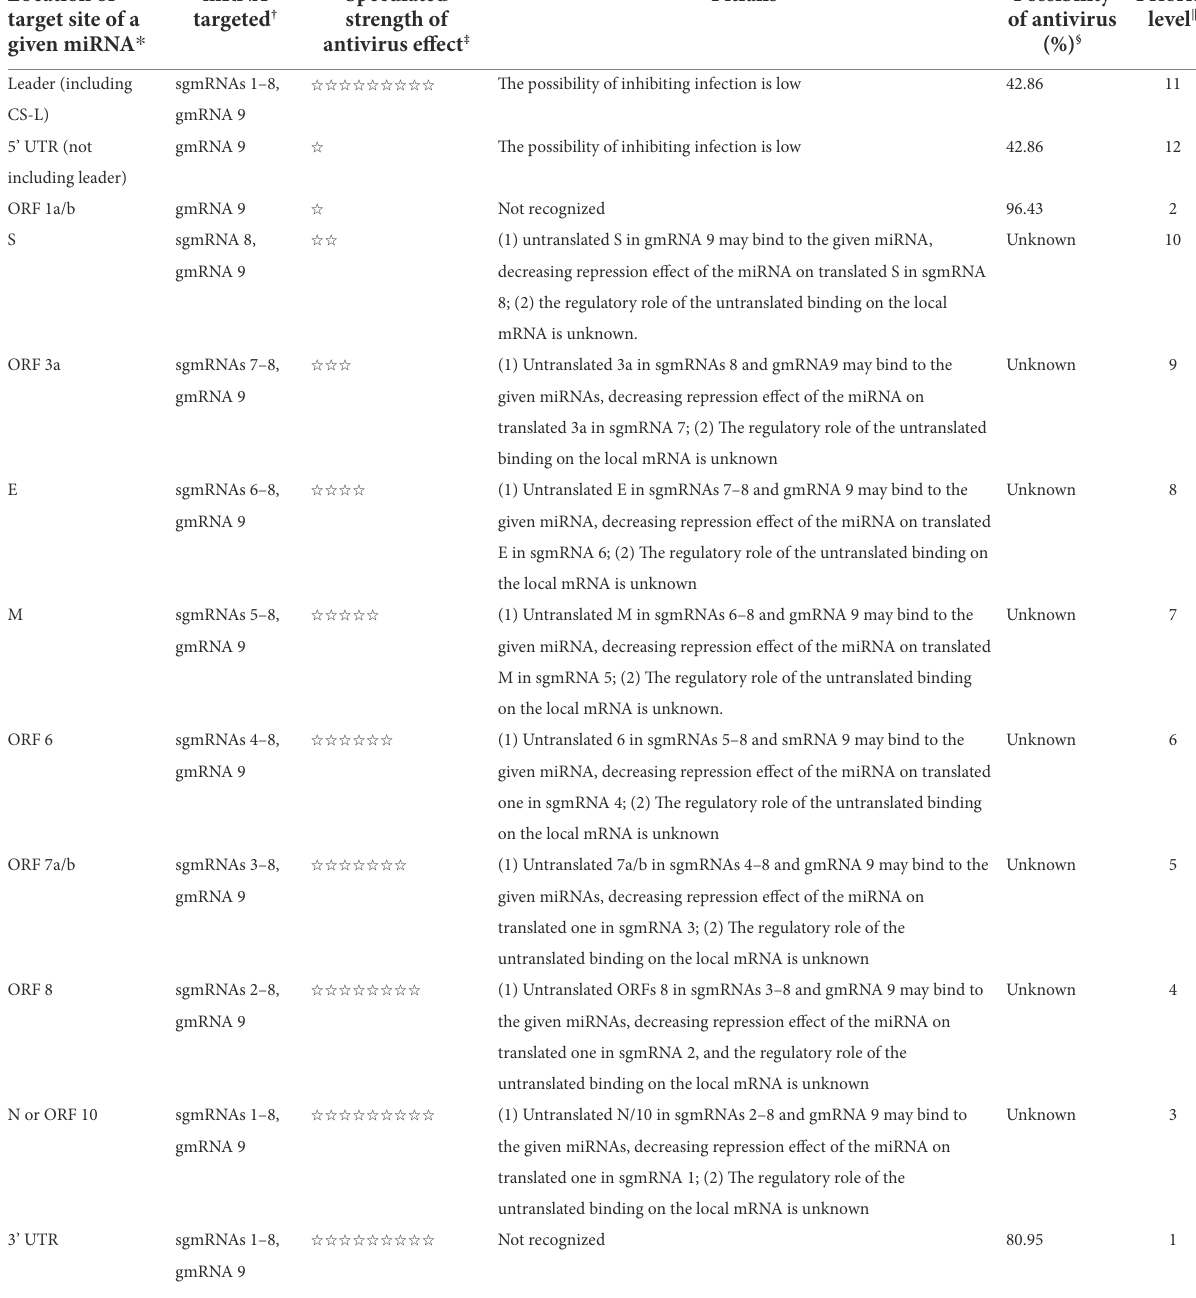
TABLE 2 The characteristics of antiviral effects mediated by a series of miRNAs targeting different regions of the HCoV genome, reported on the basis of the SARS-CoV-2 genome. Location of mRNA Speculated target site of a targeted † strength of given miRNA * antivirus effect ‡